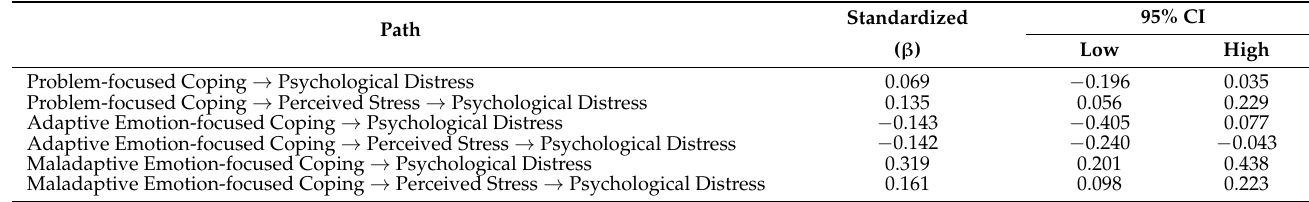
Table 2. Bias-corrected bootstrap tests on direct and indirect effects.